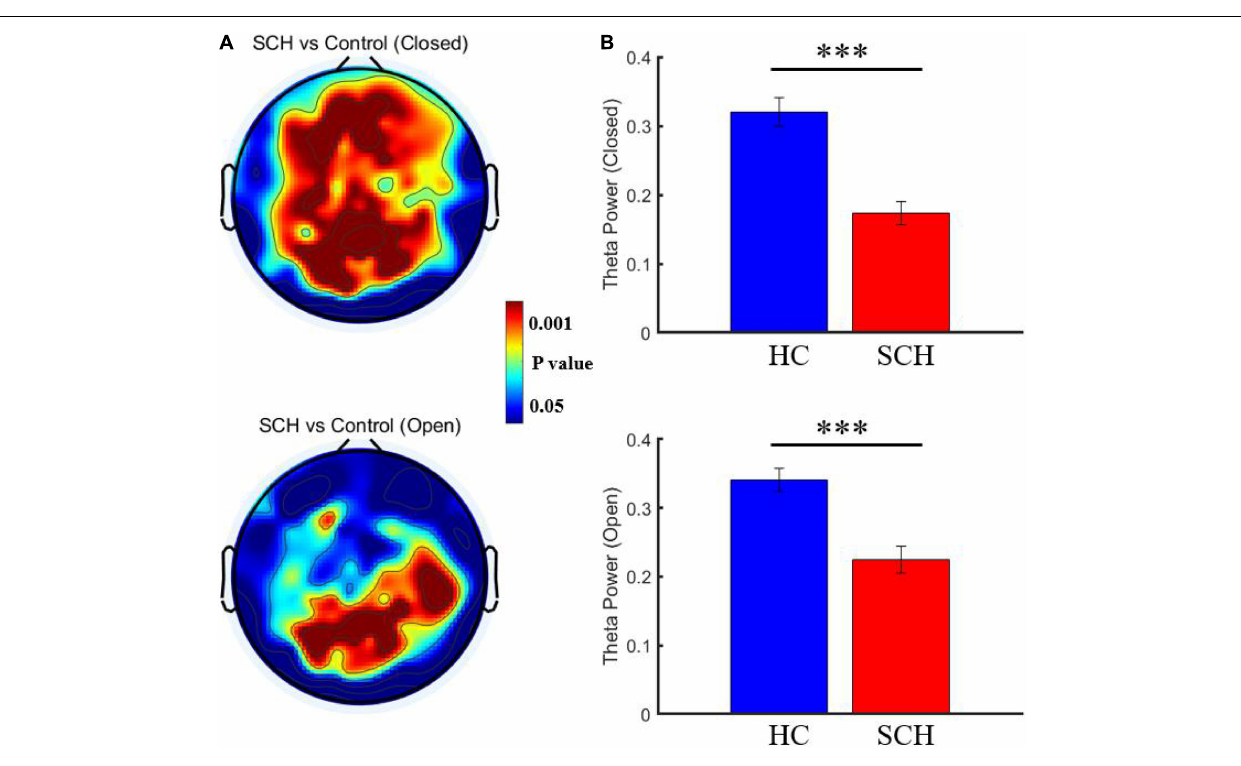
Frontiers in Human Neuroscience |